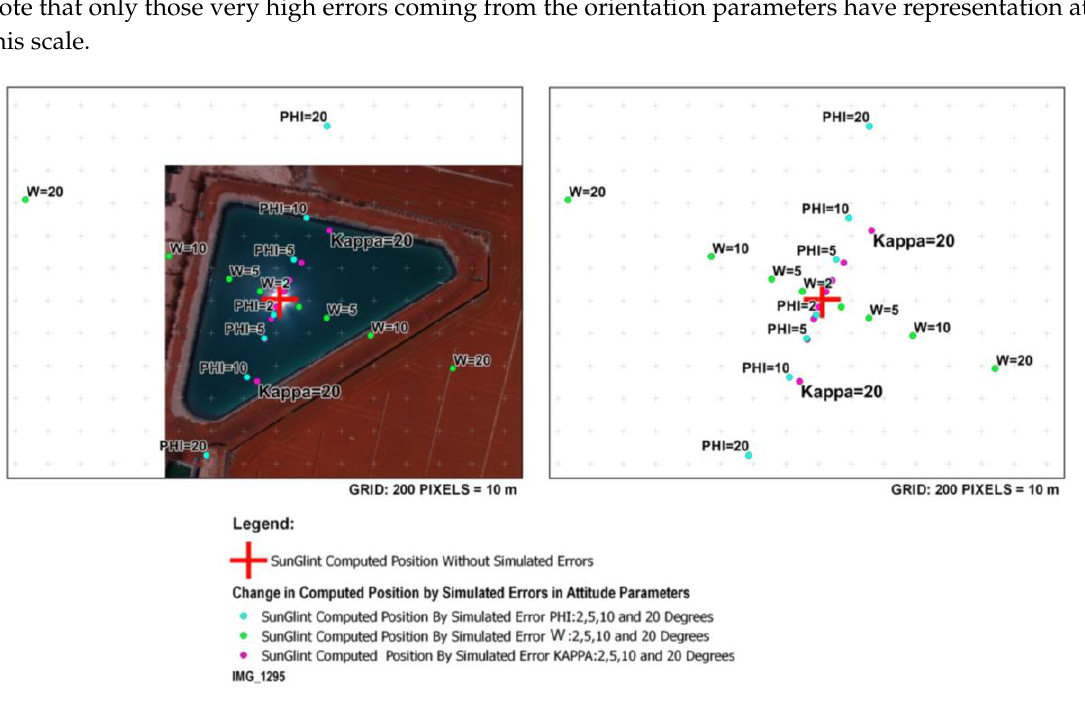
Figure 9. Analysis of errors for the detection of sun glint effects simulating different errors in angular position (omega, phi,